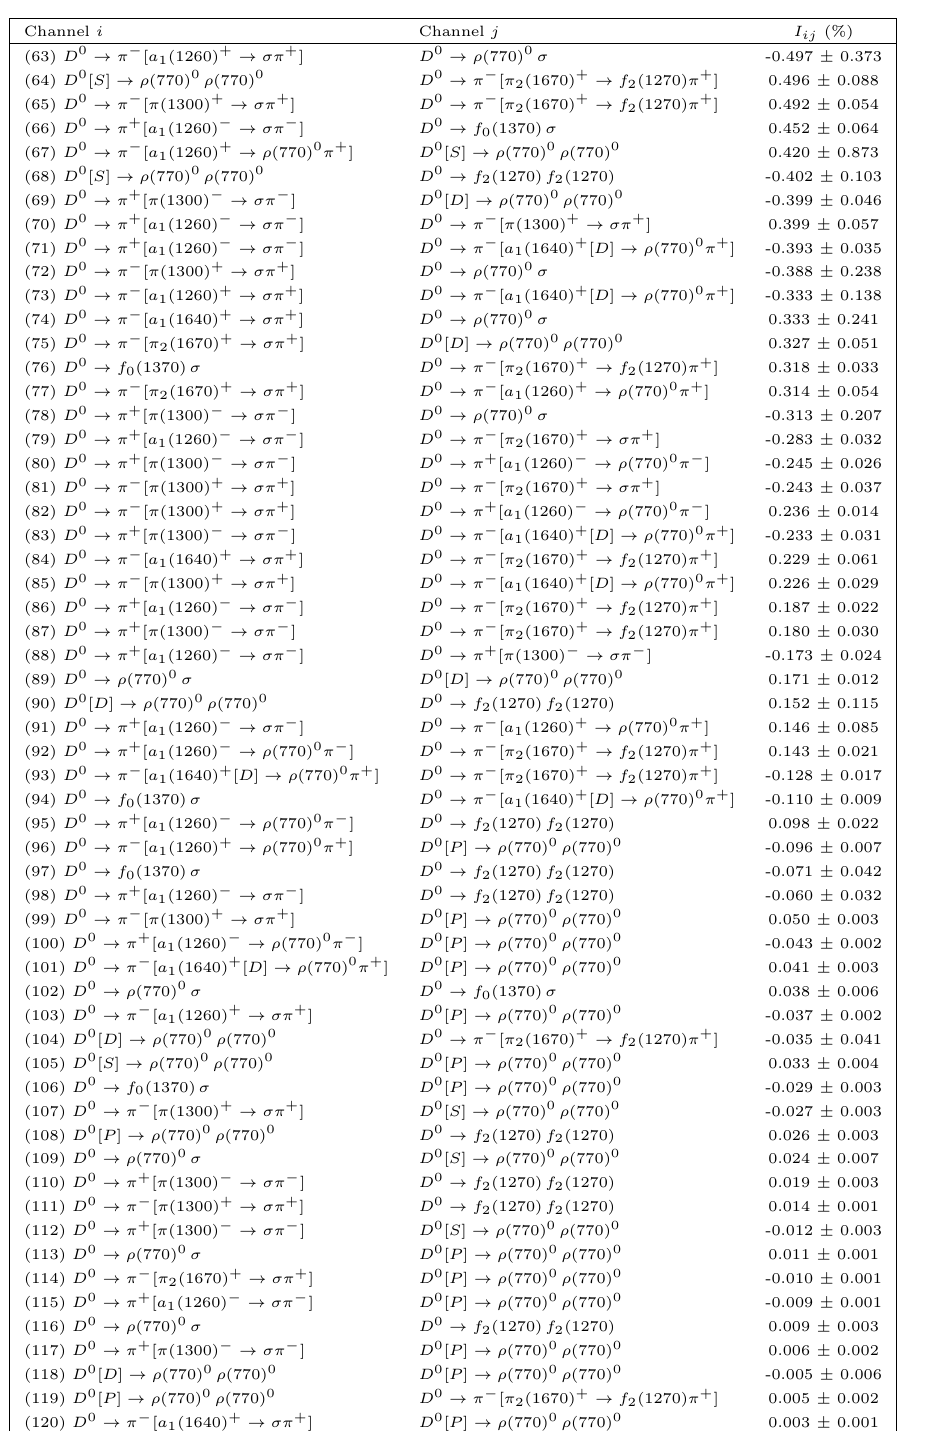
Table 22 . Interference fractions j I ij j (cid:20) 0 : 5%, as de(cid:12)ned in eq. (4.27), ordered by magnitude, for the D ! (cid:25) + (cid:25) (cid:0) (cid:25) + (cid:25) (cid:0) amplitude (cid:12)t using the LASSO model. Only the statistical uncertainties are given.